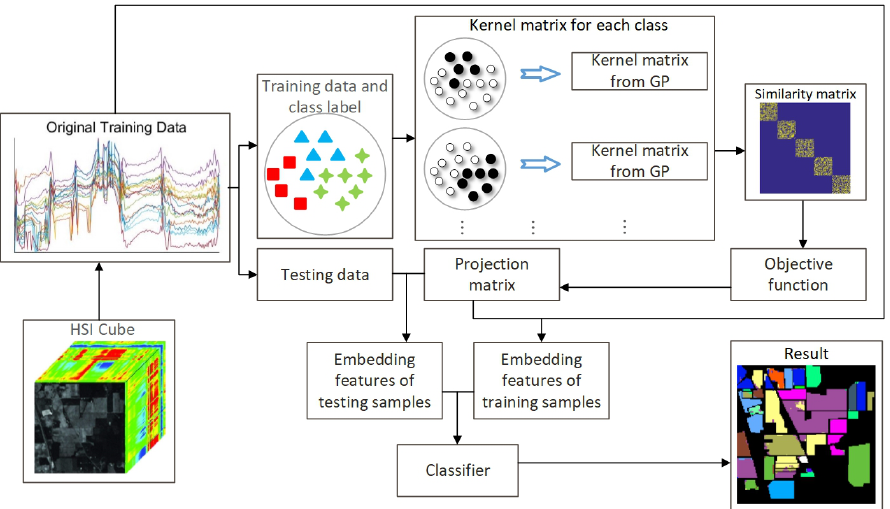
Figure 1. Flowchart of the proposed GPGDA method for HSIs feature extraction and